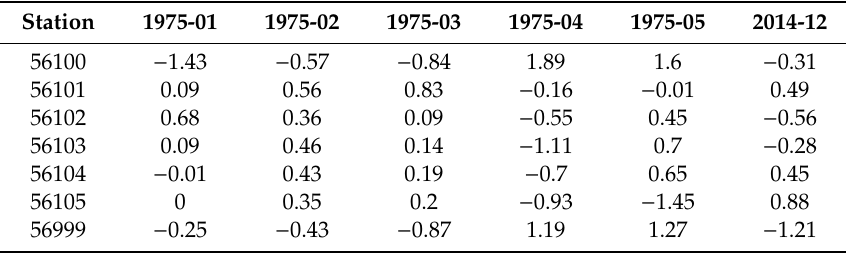
Table 2. Standardized precipitation index (SPI) (3)